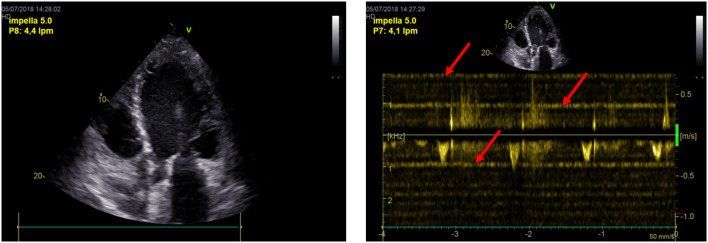
Impella's artifacts interfere in 2-dimensional echo and Doppler images of the heart.